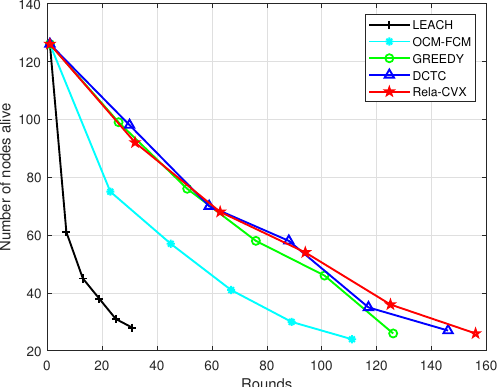
Figure 5. Number of nodes alive versus the number of iteration